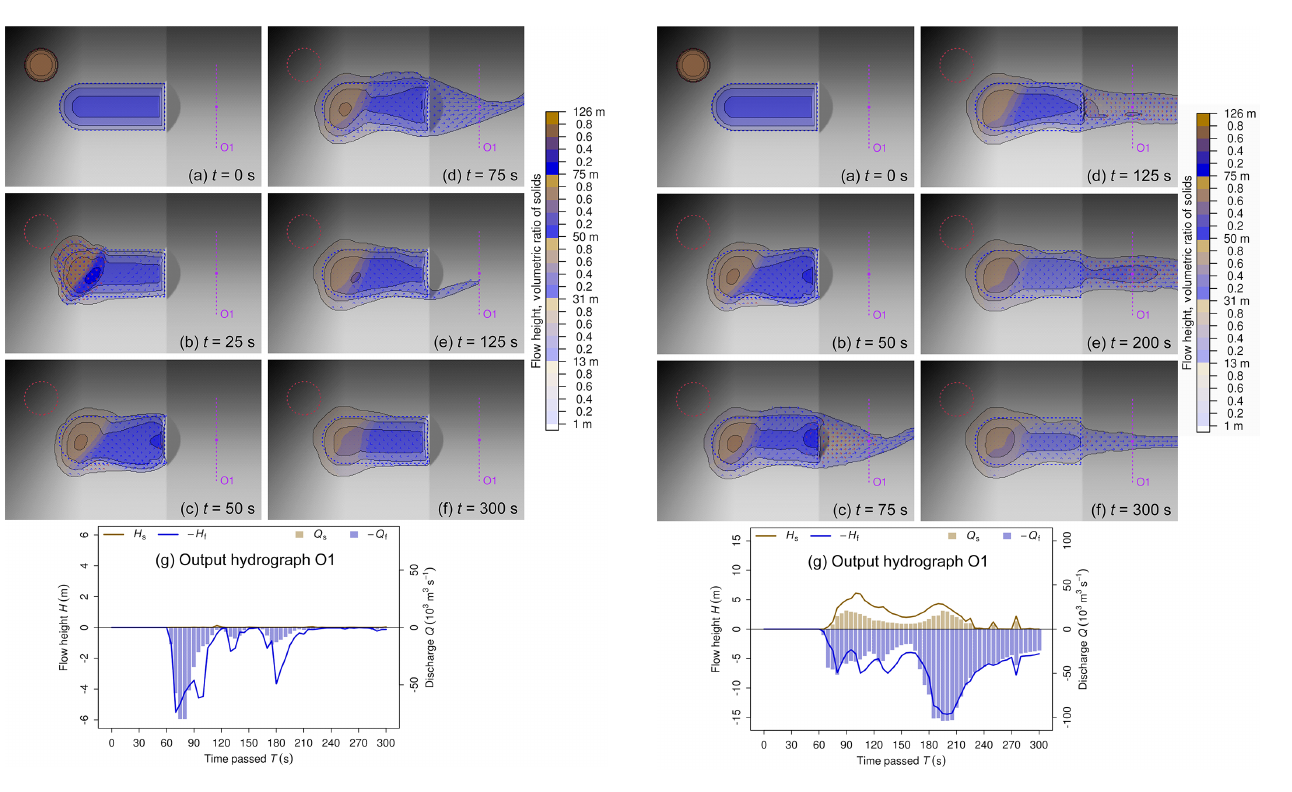
Figure 7. Key results of Experiment 1B. (a–f) Sequence of sim- ulated flow heights and solid ratios at selected points of time; see Animation 1B in the Supplement for animations of flow height se- quences; (g) output hydrograph O1 (see Fig.